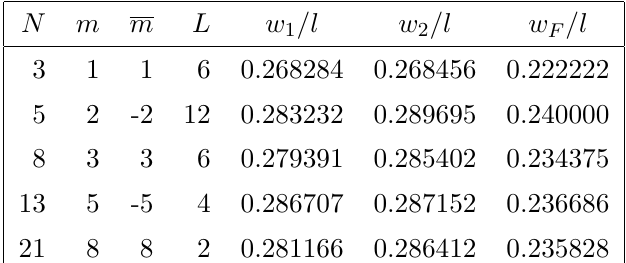
Table 2. Value of the width at half-maximum for l 0 = l 3 = l ( w 1 ) and l 0 = 2 l 3 = 2 l ( w 2 ) compared with the value of l for the Fibonacci solution ( w 0